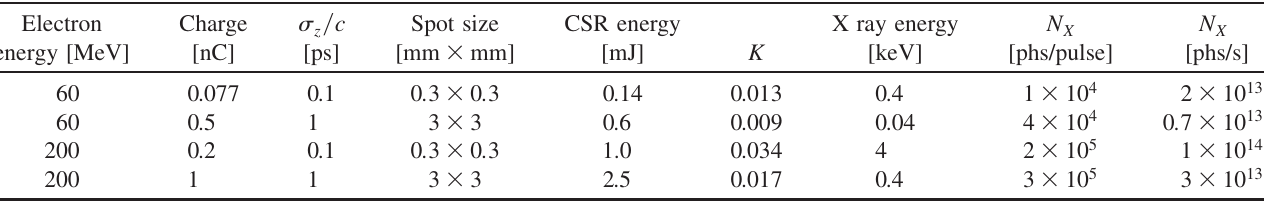
TABLE I. Optical cavity scheme in the Compact ERL: Horizontal acceptance angles are 50 mrad for (cid:2) ¼ 190 (cid:8) m and 110 mrad for (cid:2) ¼ 1900 (cid:8) m for mode matching. Bandwidth of the on-axis x ray is considered to be (cid:1) (cid:2) of the x ray is the same as (cid:3) z =c .